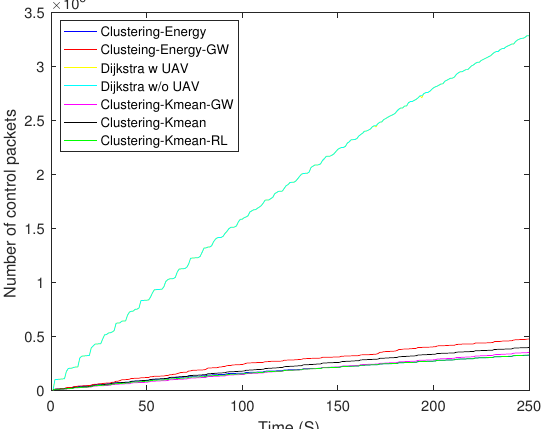
Figure 13. Control packets sent by all the schemes.